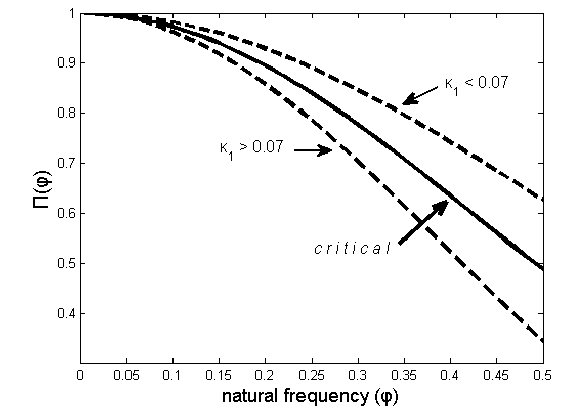
Figure 6. Time series of seismic events ( a ) in conventional time t and ( b ) in the natural time χ . ( c ) Schematic diagram showing the power spectrum Π ( φ ) in natural time. Solid line is Π ( φ ) obtained from Equation (4) for the critical stage ( κ 1 = 0.070), whereas two other lines are for κ 1 > 0.07 and κ 1 < 0.07.